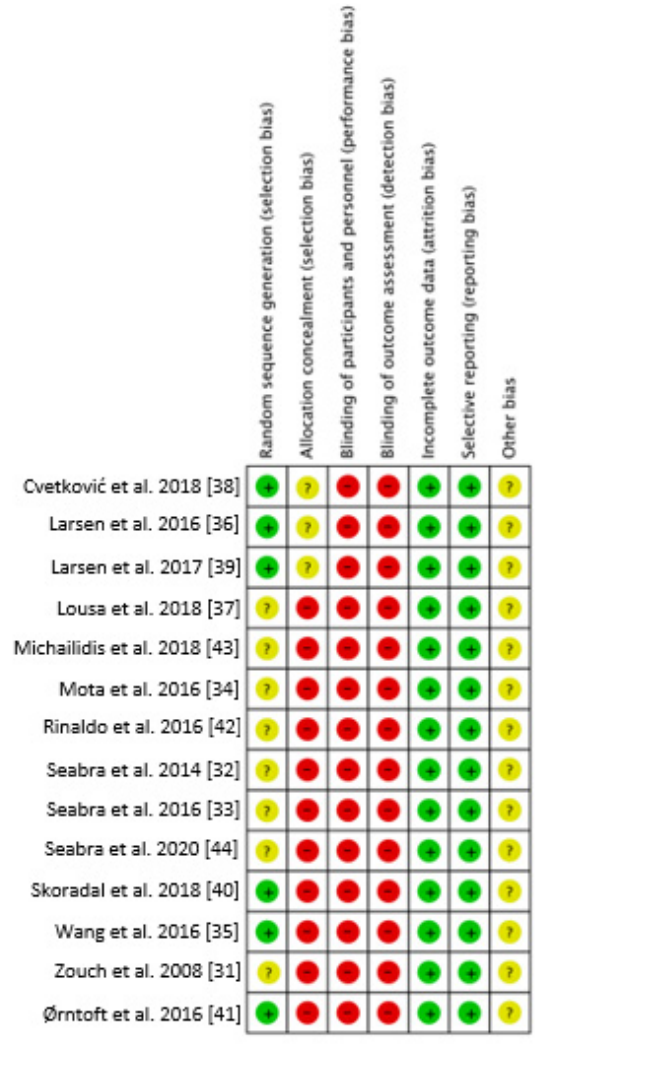
Figure 2. Risk of bias graph of the included studies. + Low risk of bias; - High risk of bias; ? Unclear risk of bias [31–44].